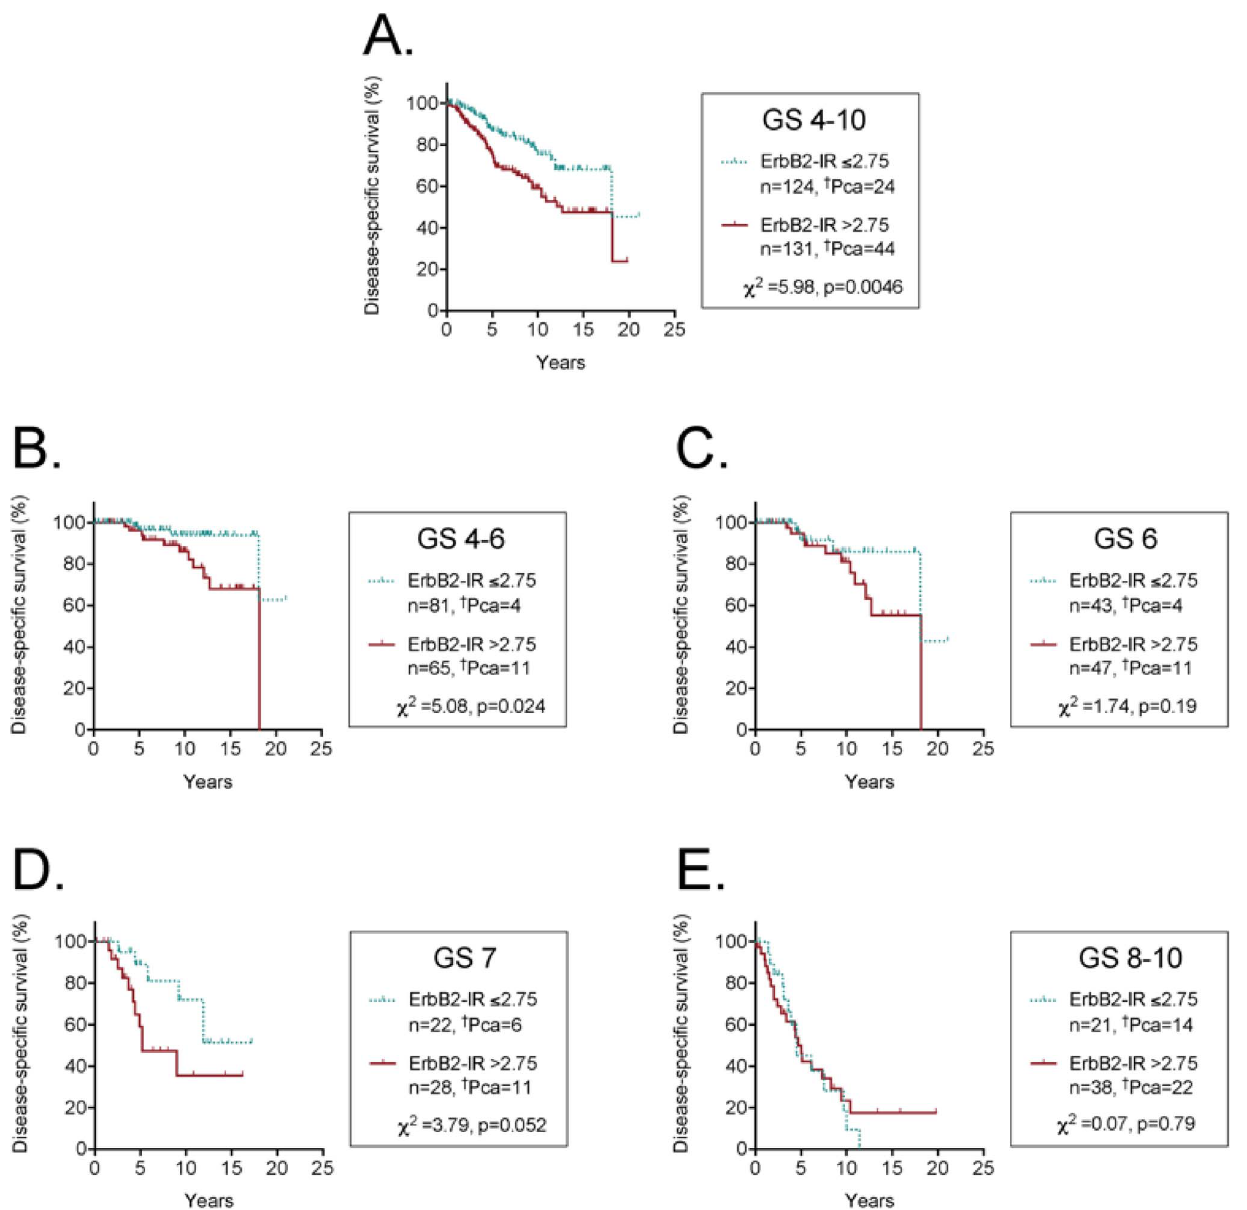
Figure 4. Kaplan-Meier plots of disease-specific survival of patients followed with active expectancy with tumour ErbB2-IR scores either below or above the optimal (Youden) cut-off value. The number of cases where death was due to prostate cancer are indicated as { Pca in the figure. The hatches on the lines show censored data (i.e. cases other than death due to prostate cancer). The range of Gleason scores (GS) for the patients are shown in each